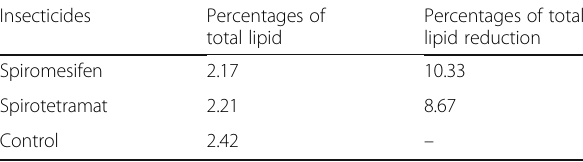
Table 2 The percentages of total lipid in the second instar larvae of S . littoralis treated by spiromesifen and spirotetramat